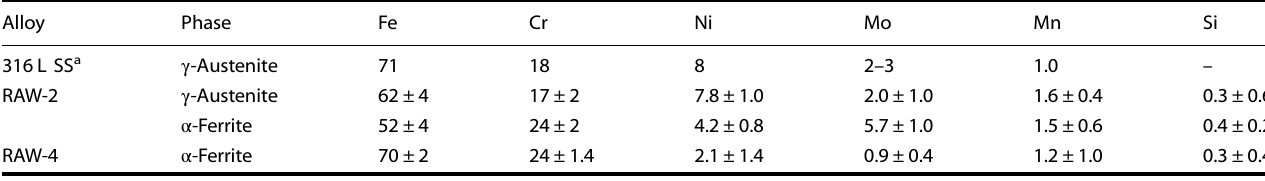
Table 4. Cr, Mo, and Ni contents of the austenite and ferrite phases in the three alloys, in